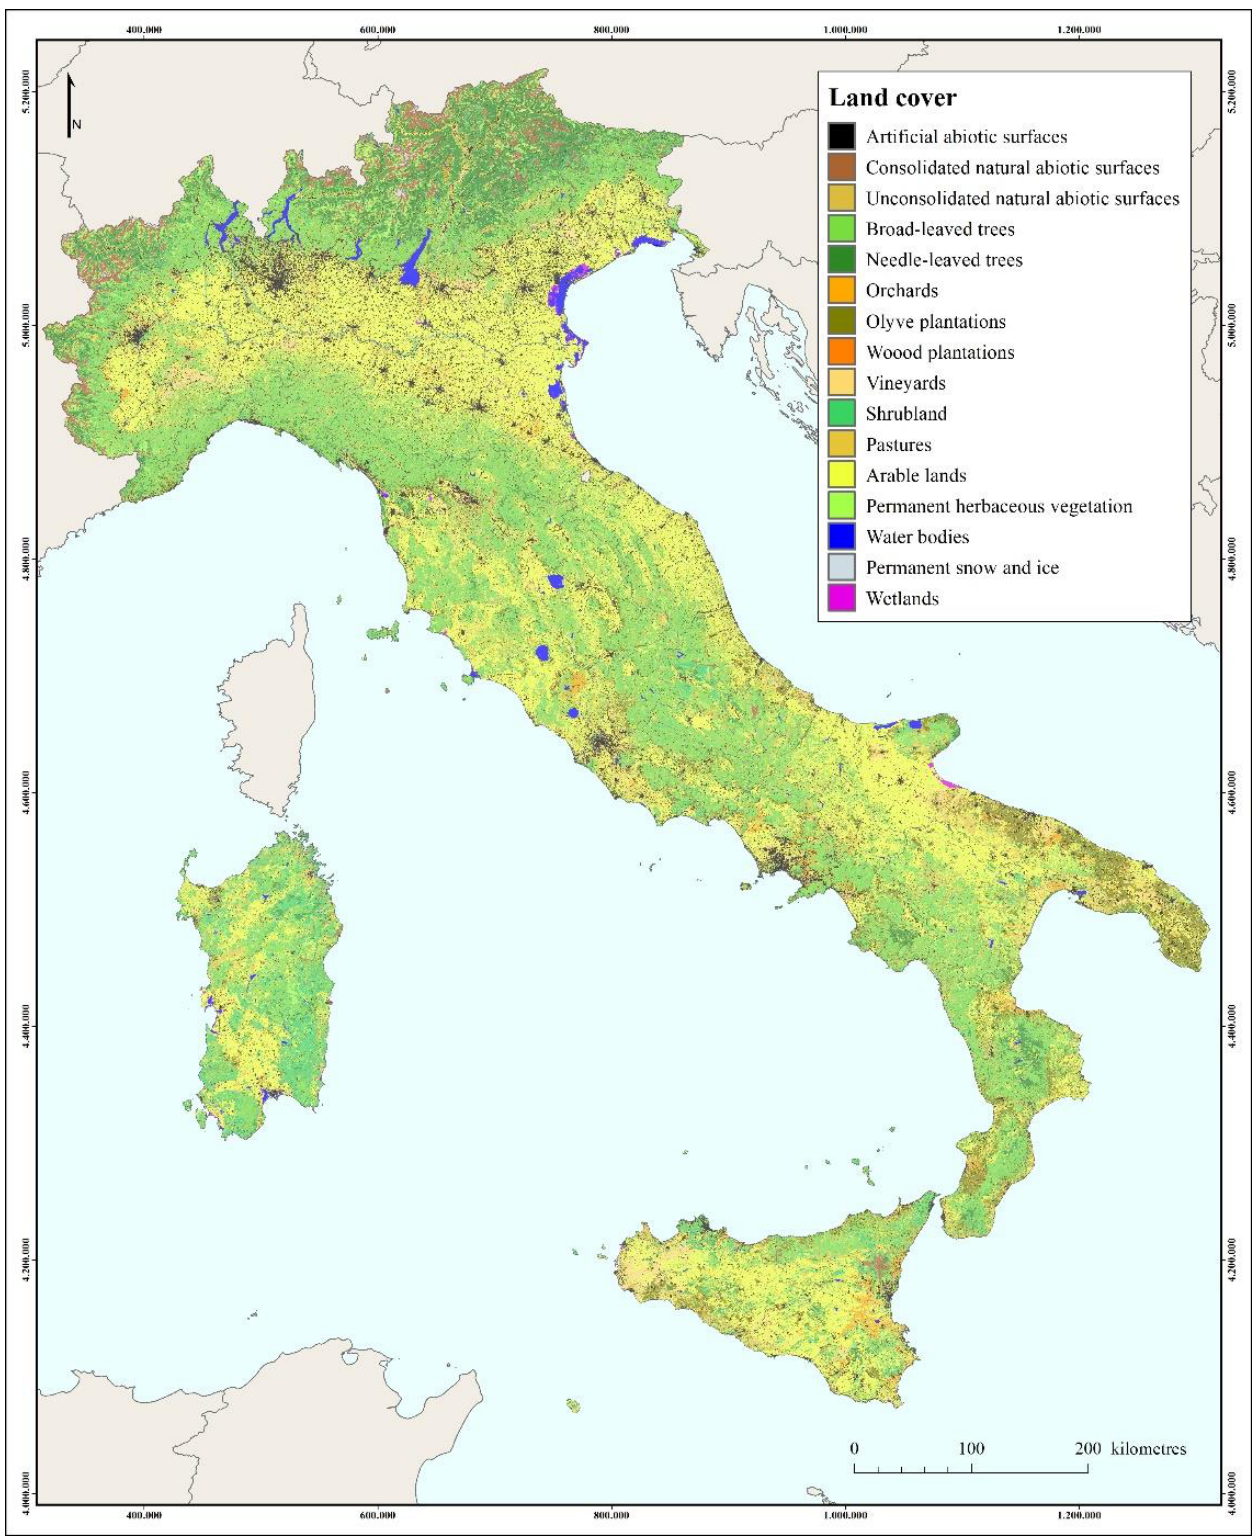
Figure 3. Land cover map of Italy for 2012.